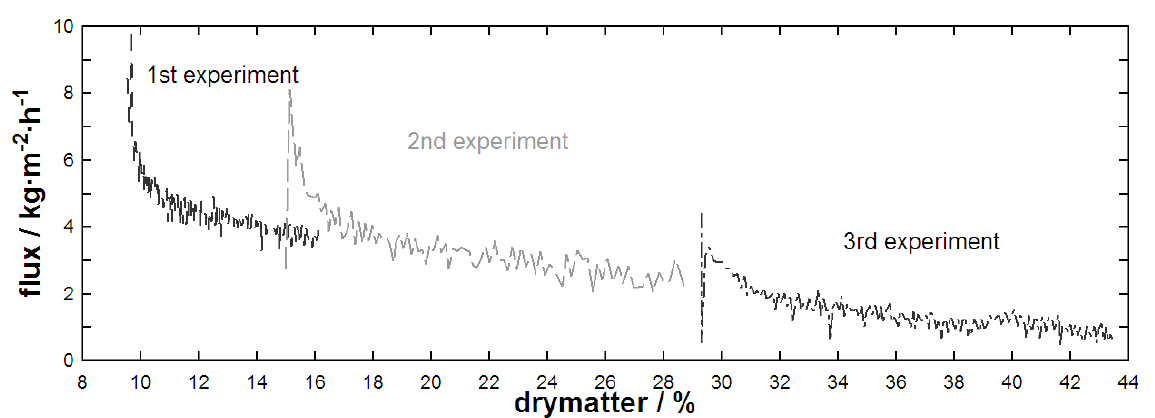
Figure 5. Flux during DCMD of skim milk powder solutions at different initial concentrations.